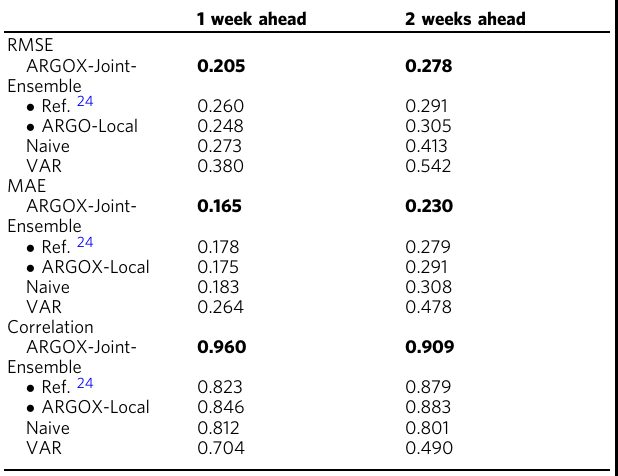
The averaged RMSE, MAE, and correlation across 51 states are reported for each forecasting horizon and best performed method is highlighted in boldface. On average (across forecasting horizon),ARGOX-Joint-Ensembleachievesaround11%RMSEand12%MAEand7%Correlation improvements from ref. 22